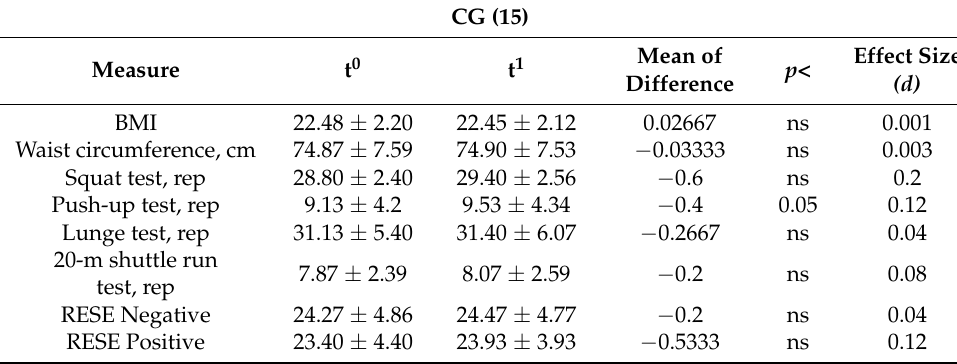
Table 4. Analysis of control